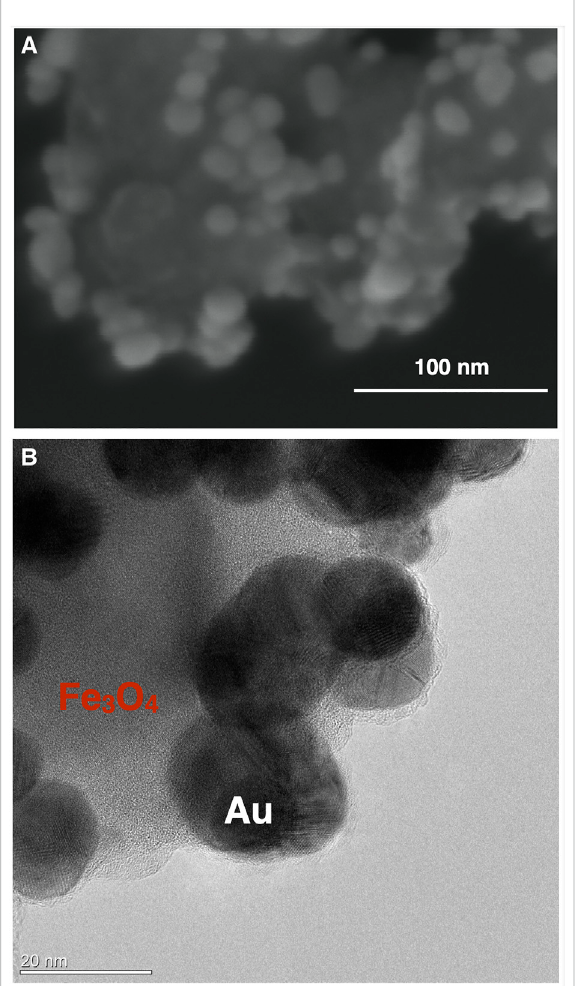
FIGURE 9 Electron microscopy images of multifunctional magneto- plasmonic nanosorbents: SEM (A) and TEM (B) images. The magnetic drivers are Fe 3 O 4 particles decorated with SERS active Au